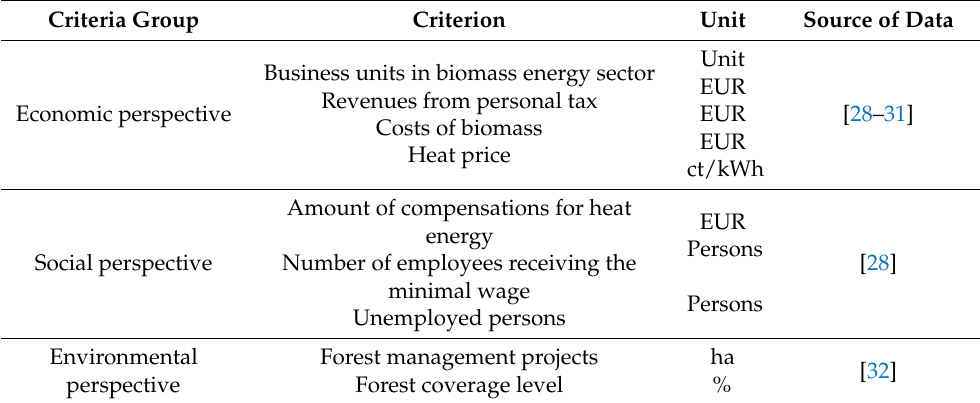
Table 2. Required data for the research.